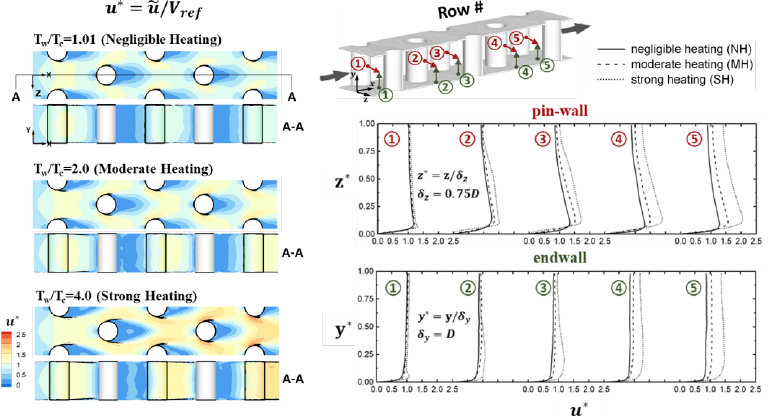
Figure 12. Mean streamwise velocity contours and profiles for T w /T c = 1.01 (NH), 2.0 (MH), and 4.0 (SH). Energies 2023 , 16 , x FOR PEER REVIEW